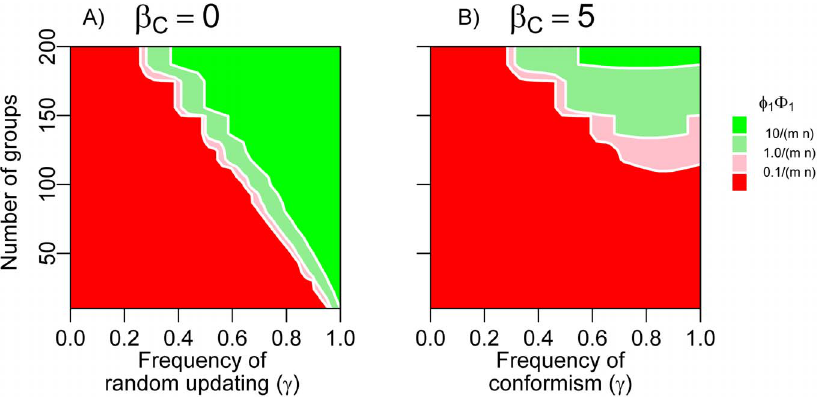
Figure 4. Effect of conformism on the evolution of cooperation by cultural group selection. Panels show fixation probability of cooperation in a group-structured population where initially only a single individual cooperates. Within groups, payoff-based learning favours defection, but cooperation can spread between groups by occasional learning outside of the local group, because individuals in cooperative groups have higher payoffs. The number of groups m was varied between 10 and 200, in steps of 5, holding the metapopulation size constant at m n =1000. The frequency of conformist updating was varied between 0 and 1, in steps of 0.01. In (A), b C is equal to zero, corresponding to random updating, while the conformism-based updating has a strong effect ( b C =1) in (B). Hence, panel (A) should mainly be viewed as a reference for panel (B). We used an interpolation procedure (using the R-package ‘akima’) to smoothen the plots. Colours facilitate comparison to the fixation probability of a selectively neutral mutant 1/( m ? n ). The payoff matrix coincides with that of the social dilemma game in Figure 1.